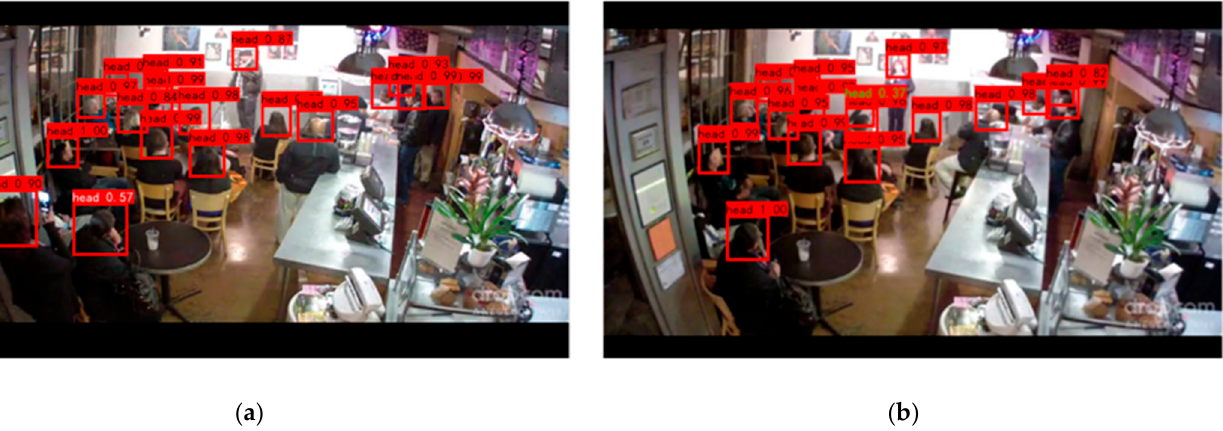
Figure 10. Test results with DPAC: ( a ) detection result with DPAC with 18 people; ( b ) detection result without DPAC with 16 people.